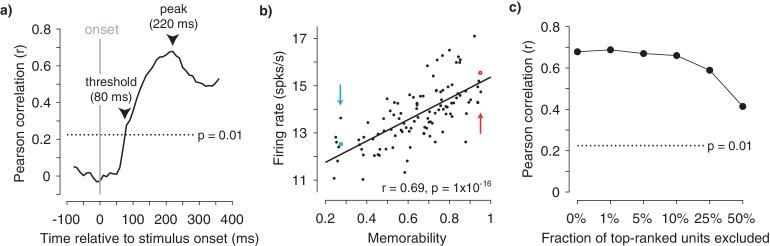
The correlation of memorability and the IT population response, applied to different time windows, assessed with firing rate, and determined with top-ranked firing units removed.(a) The same analysis described for Figure 2b, but applied to 80 ms windows shifted at different positions relative to stimulus onset, where the correlations are plotted against the center of each time bin. Figure 2b is shown at the peak of this plot (220 ms). Also shown (dotted line) is the critical correlation threshold for p<0.01, which the population reached at 80 ms following stimulus onset. (b) Correlations between memorability and grand mean firing rate across the 707 units (in contrast to the plots of response magnitude in Figure 2b). The two example images from 2b are indicated. Solid line depicts the linear regression fit to the data. (c) The analysis in Figure 2b with N% top-ranked firing rate units excluded from the pseudopopulation for different N. The dotted line indicates the critical correlation for the significance level p=0.01.